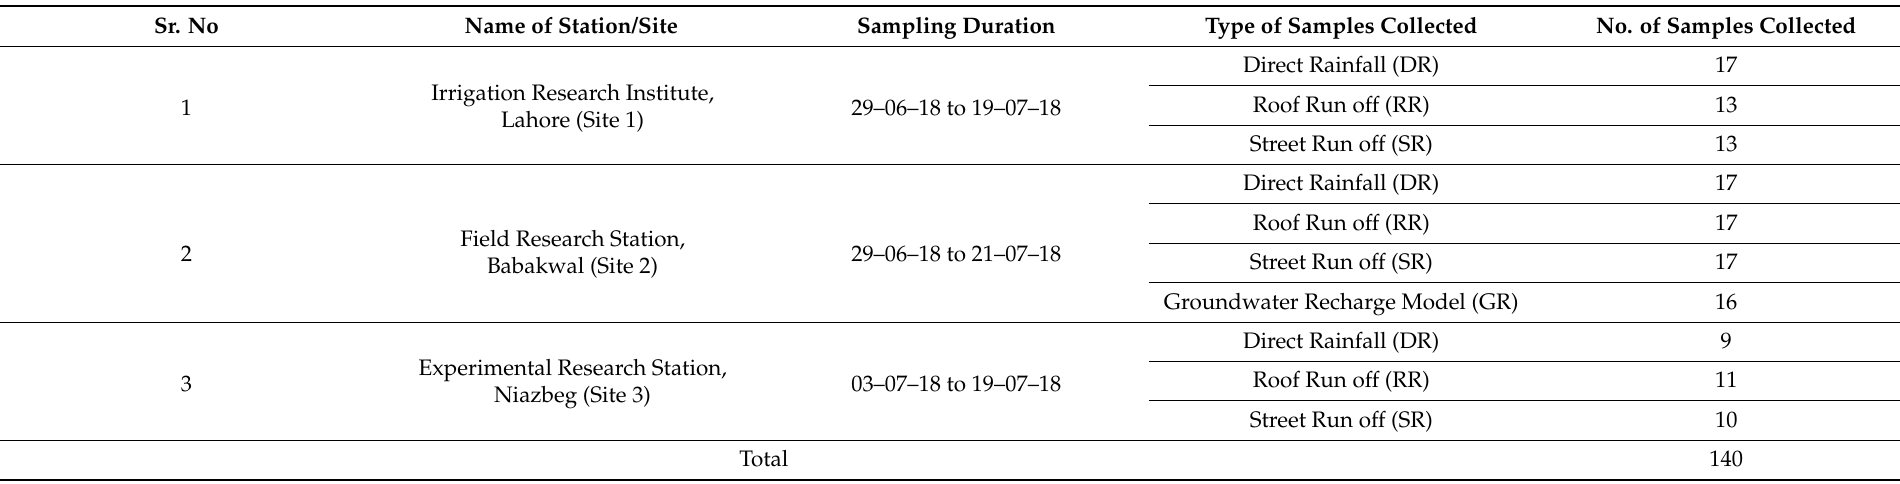
Table A1. Collection of rainwater samples from different sites.